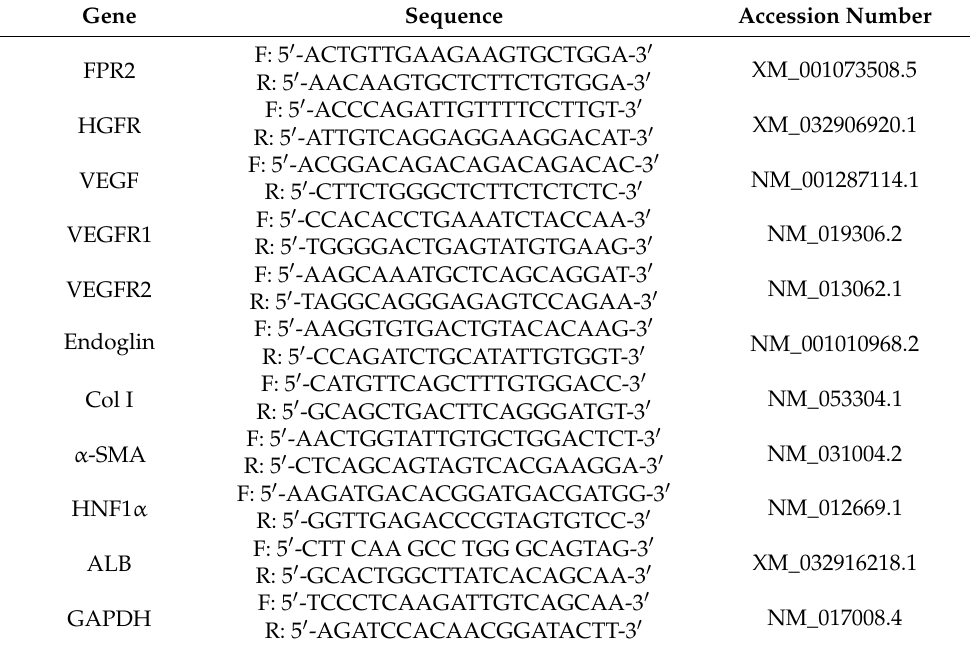
Table 1. Primer sequences using quantitative real time polymerase chain